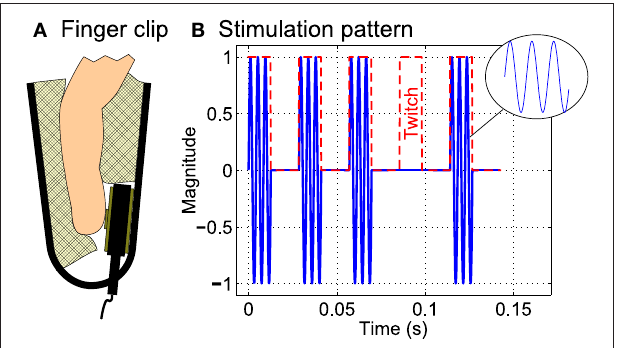
FIGURE 2 | Tactile stimulation. (A) Two C-2 tactors were attached to the left and right index finger using finger clips. (B) The tactile stimulation pattern consisted of a 237Hz sinusoidal carrier signal which was amplitude modulated with a rectangular stimulation signal (red dashed line) of the respective stimulation frequency (here: 35Hz). Twitches were implemented as complete interruption of the stimulation signal for exactly one stimulation period.